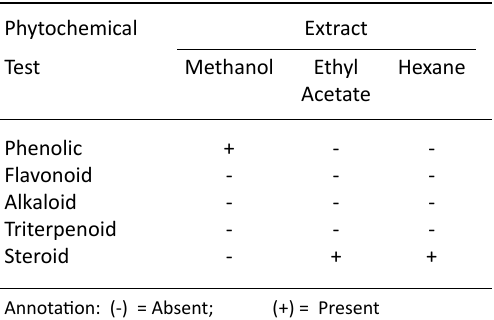
Table 3. Phytochemical test results from crude extracts of MA1 microalgae Phytochemical